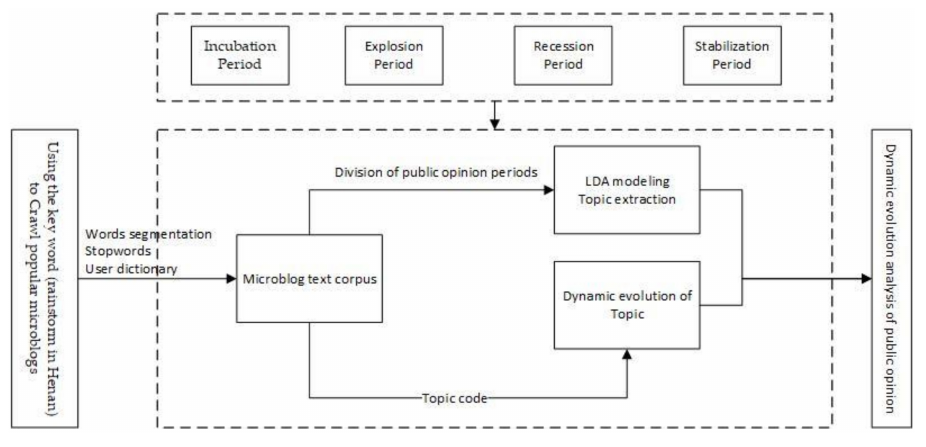
Figure 2. The research